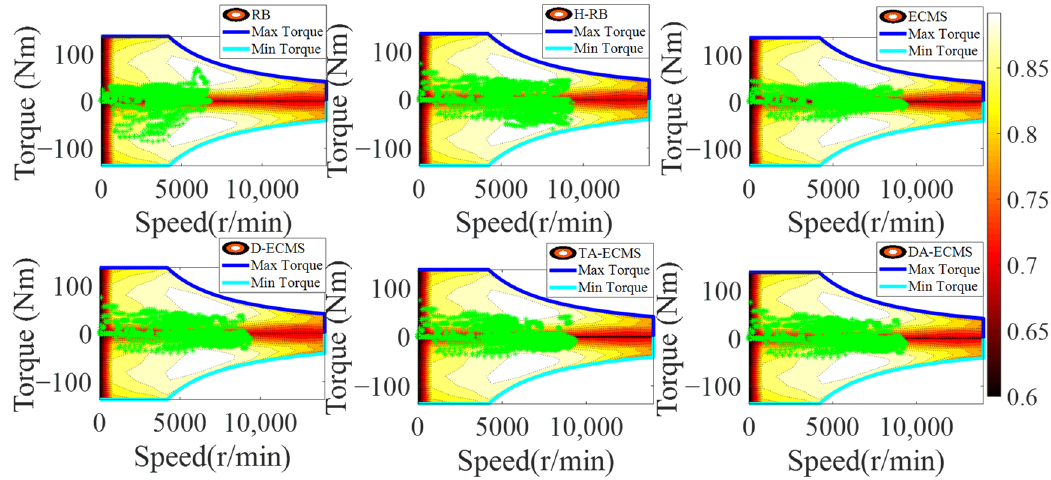
Figure 16. Front motor operating points of energy management strategies.